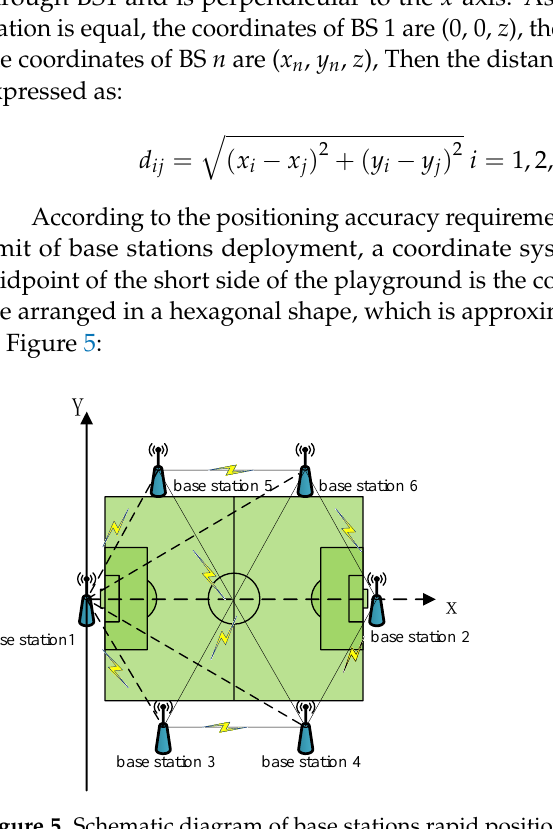
Figure 5. Schematic diagram of base stations rapid positioning. According to Formula (20), the nonlinear equations about distance and base station coordinates can be obtained. In this work, the Least Square method and Newton iteration method are used to solve the final coordinates of the base stations. The specific method is as